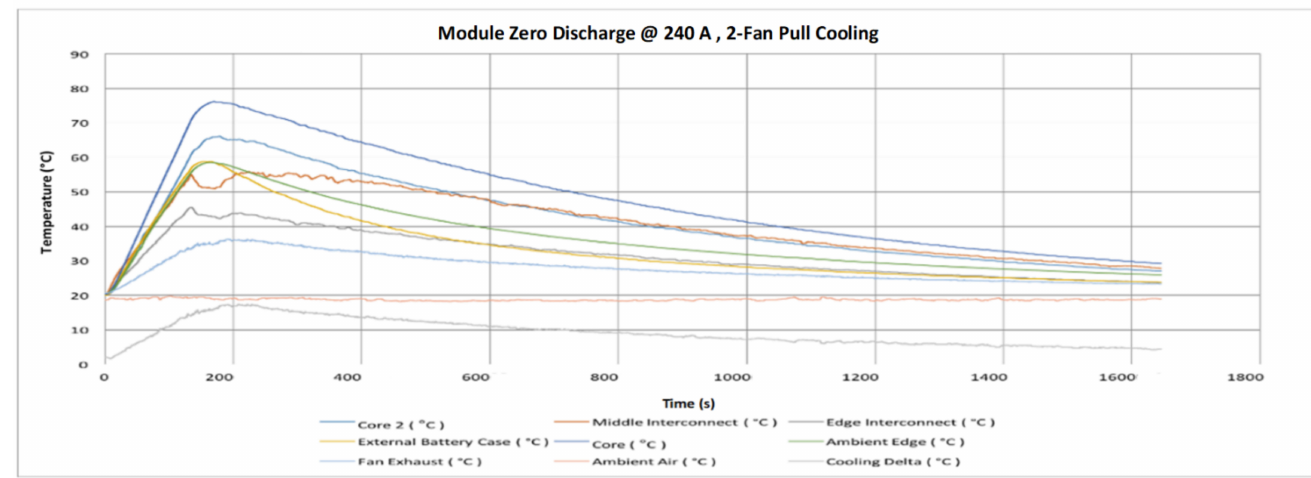
Figure 17. Module zero discharge, 240 A 2-fan pull cooling.